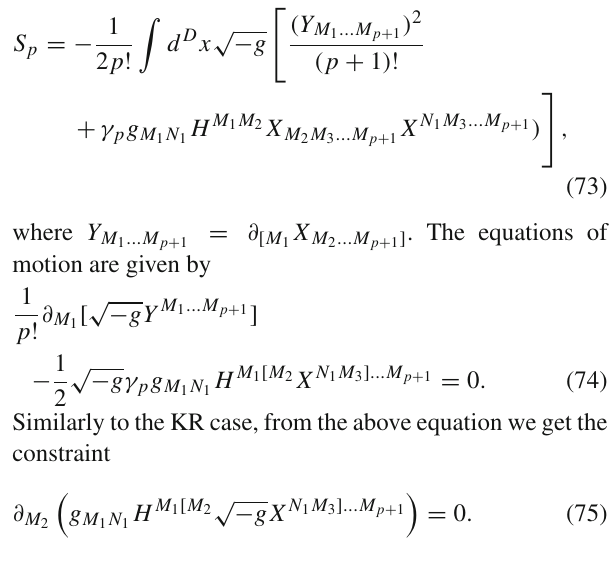
. a Horndeski coupling and b Riemann T